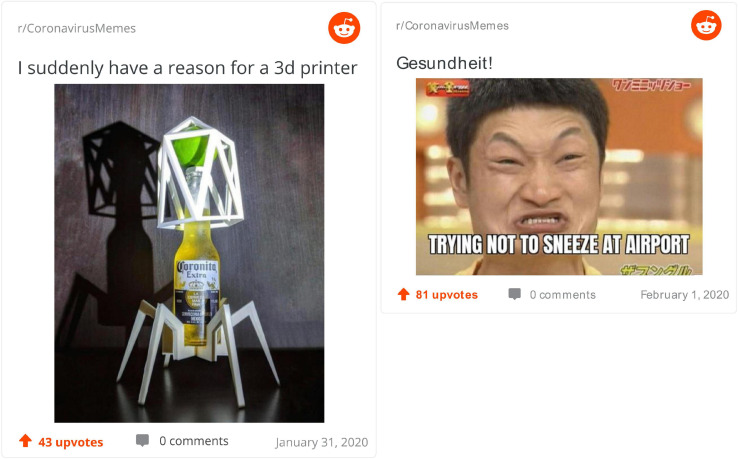
Top funny memes.